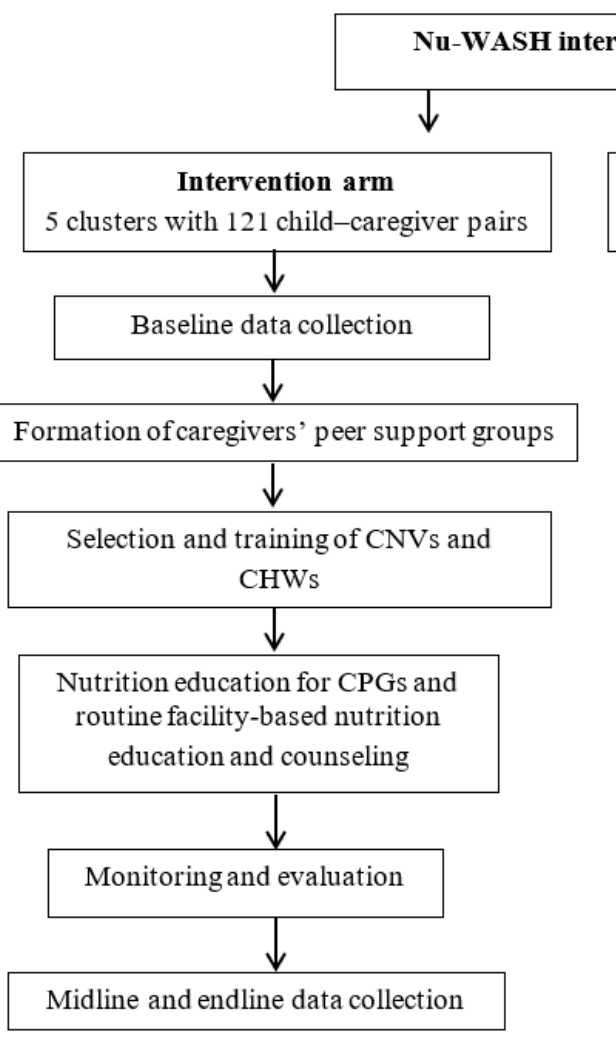
Figure 3. Summary of treatment given in the intervention and control arms. CHW: community health workers; CNV: community nutrition volunteers; Nu-WASH; nutrition, water, sanitation, and